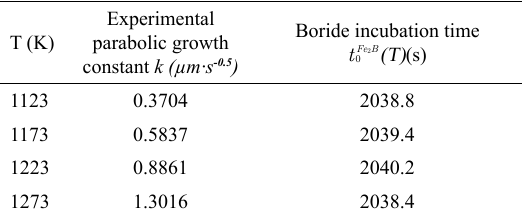
Table 2. Experimental values of parabolic growth constants at the (Fe B/substrate) interface along with the corresponding boride 2 incubation